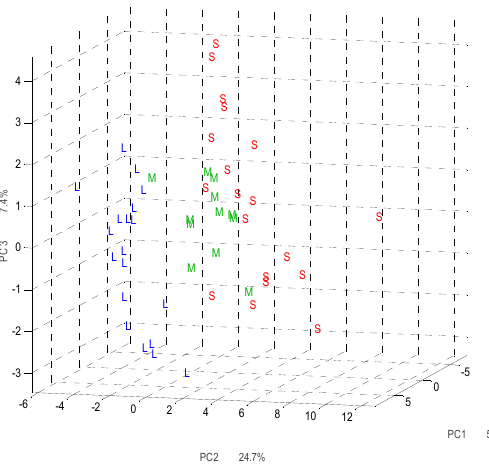
Figure 13. Multivariate data analysis of FTIR data using the principal component analysis (PCA). L: leaf-derived lignin, M: mixture-derived lignin, S: stem-derived lignin. Reprinted from [27] under open access license.